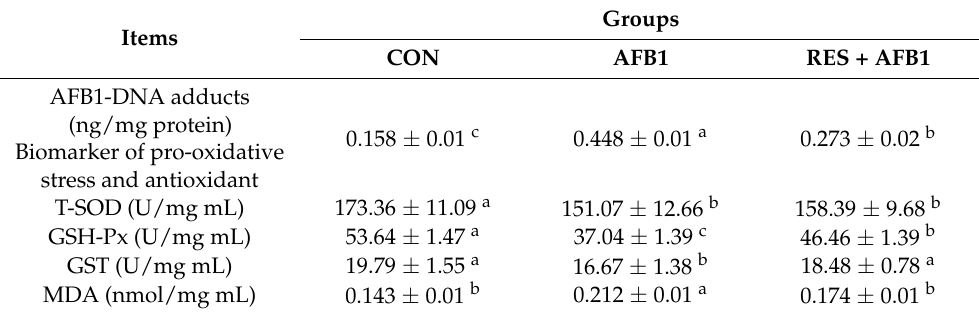
Table 1. Effect of RES on the AFB 1 -DNA adducts level and the antioxidant capacity in the plasma of AFB 1 -exposed